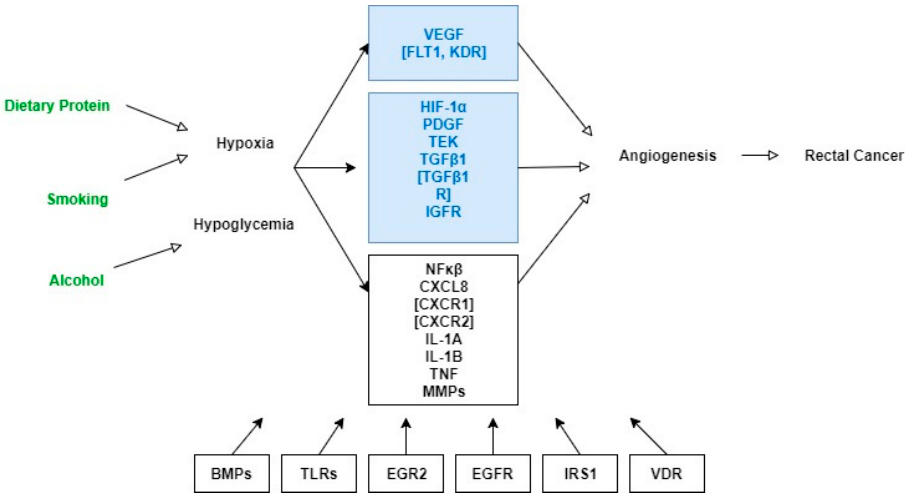
Figure 1. Working Figure of the Angiogenesis Pathway Genes. Key gene components of pathway in blue frames: VEGF = vascular endothelial growth factor; FLT1 = vascular endothelial growth factor receptor 1; KDR = vascular endothelial growth factor receptor 2; HIF-1 = hypoxia-inducible factor 1; PDGF = platelet-derived growth factor; TEK = TEK receptor tyrosine kinase; TGF β = Transforming growth factor, beta; TGF β R = Transforming growth factor, beta receptor; IGFR = insulin-like growth factor receptor. Secondary interacting genes of pathway in black frames: NF-kB = nuclear factor of kappa light polypeptide gene enhancer in B-cells; CXCL8 = C-X-C motif chemokine ligand 8; CXCR1 = C-X-C motif chemokine receptor 1; CXCR2 = C-X-C motif chemokine receptor 2; IL-1A = interleukin-1, alpha; IL-1B = interleukin-1, beta; TNF = tumor necrosis factor; MMPs ( MMP1 , MMP3 , MMP7 , MMP9 ) = matrix metallopeptidases; BMPs ( BMP1 , BMP2 , BMP4 , BMPR1A , BMPR1B , BMPR2 , GDF10 ) = bone morphogenetic proteins; TLRs ( TLR2 , TLR3 , TLR4 ) = toll-like receptors; EGR2 = early growth response 2; EGFR = epidermal growth factor receptor; IRS1 = insulin receptor substrate 1; VDR = Vitamin D Receptor. Environmental factors in green